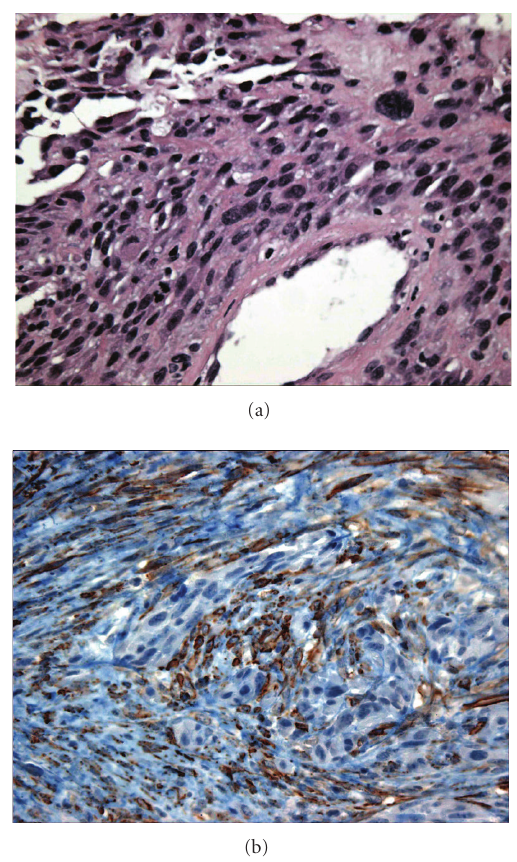
Figure 2: (a) Malignant spindle cells, pleomorphism, and high nu- cleocytoplasmic ratio. (b) Immunostain positive for smooth muscle